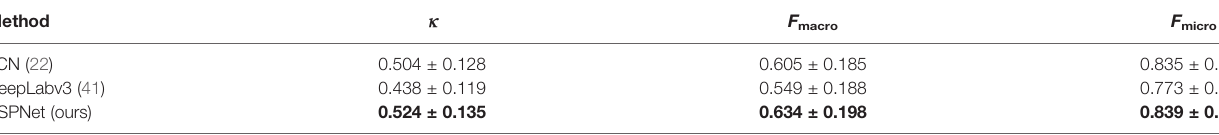
TABLE 3 | Pixel-level Gleason grade prediction of different methods.